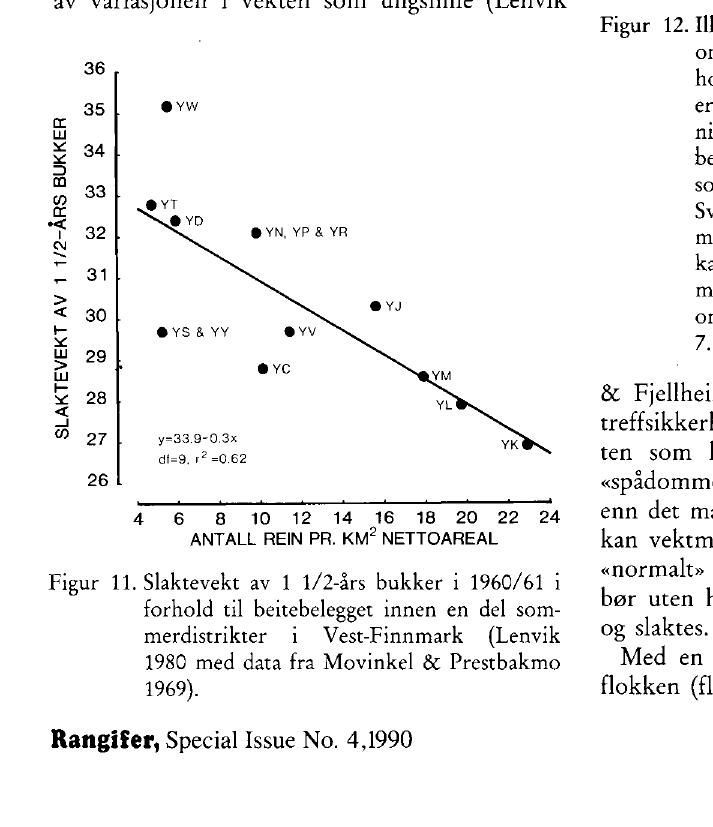
Figur 11. Slaktevekt av 1 1/2-års bukker i 1960/61 i forhold til beitebelegget innen en del som- merdistrikter i Vest-Finnmark (Lenvik 1980 med data fra Movinkel & Prestbakmo 1969).